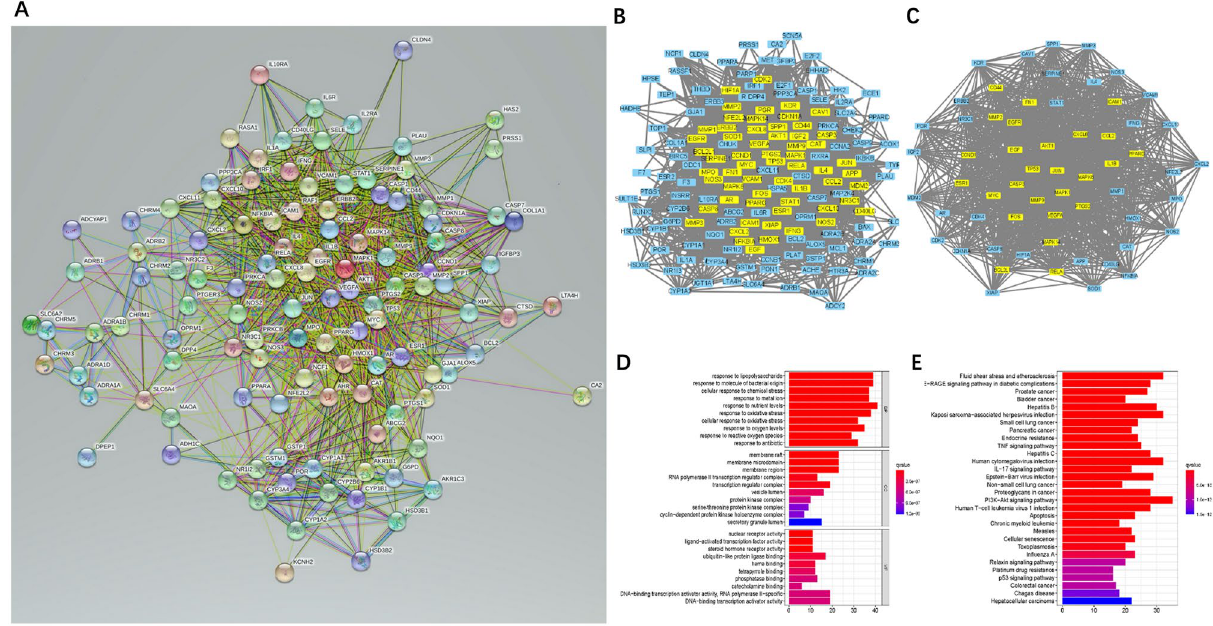
Figure 2. WLZYW core targets and pathway prediction. ( A ) PPI network of 160 potential targets. ( B ) Primary core network modules (yellow) identifying potential targets were analyzed via Cytoscape 3.8.0. ( C ) The core network module (yellow) was screened again from the core targets in ( A ). GO ( D ) and KEGG ( E ) maps of the core network. Drawing was performed by R